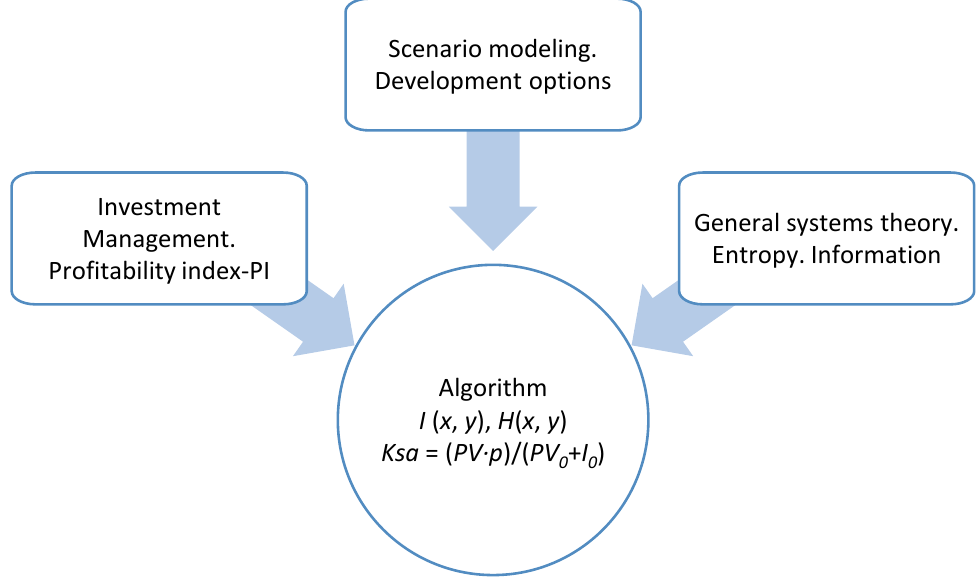
Figure 1. Visual representation of the methodological basis of the study